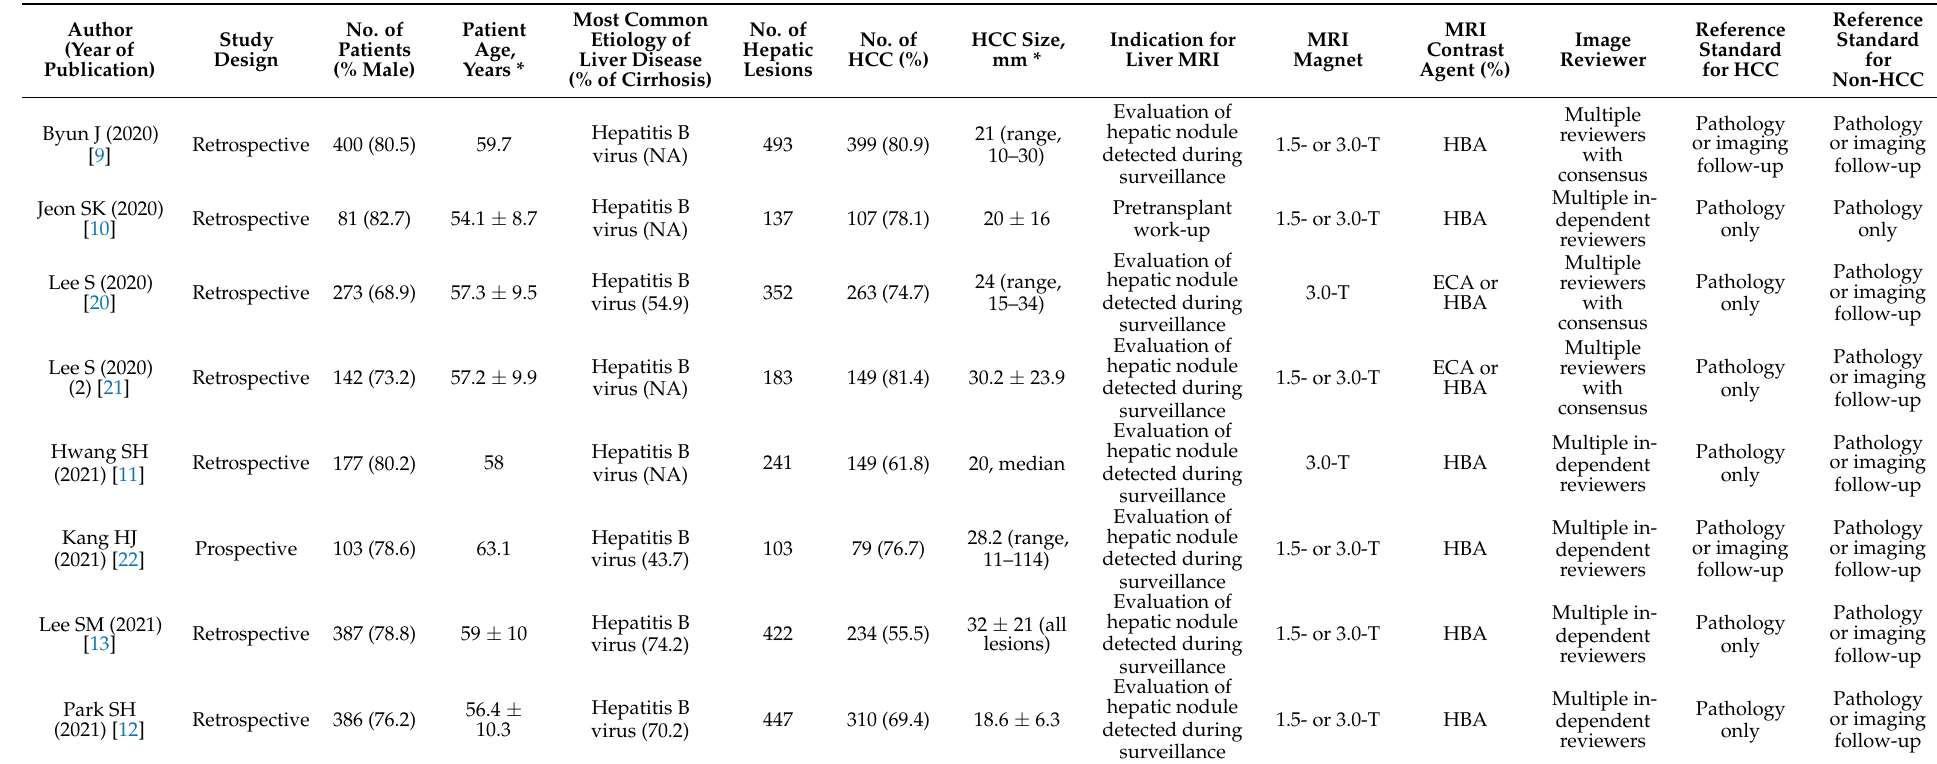
Table 1. Characteristics of the included